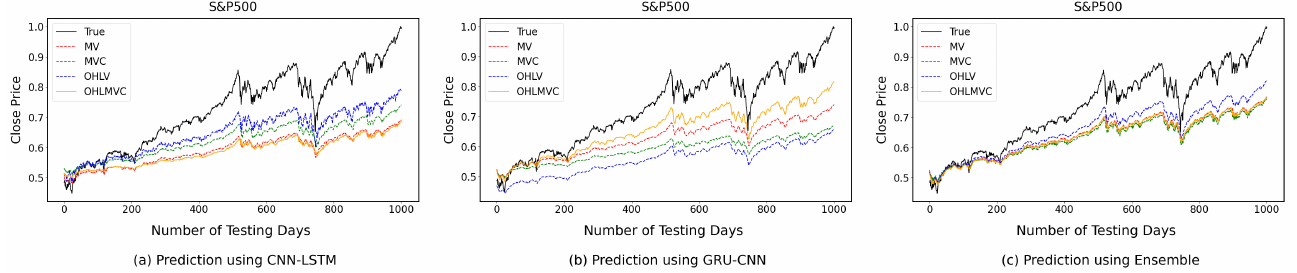
Figure 8. Comparison of true and predicted close prices of the S&P500 index between different input features for one-time-step prediction over the period from 1 January 2000 through 31 December